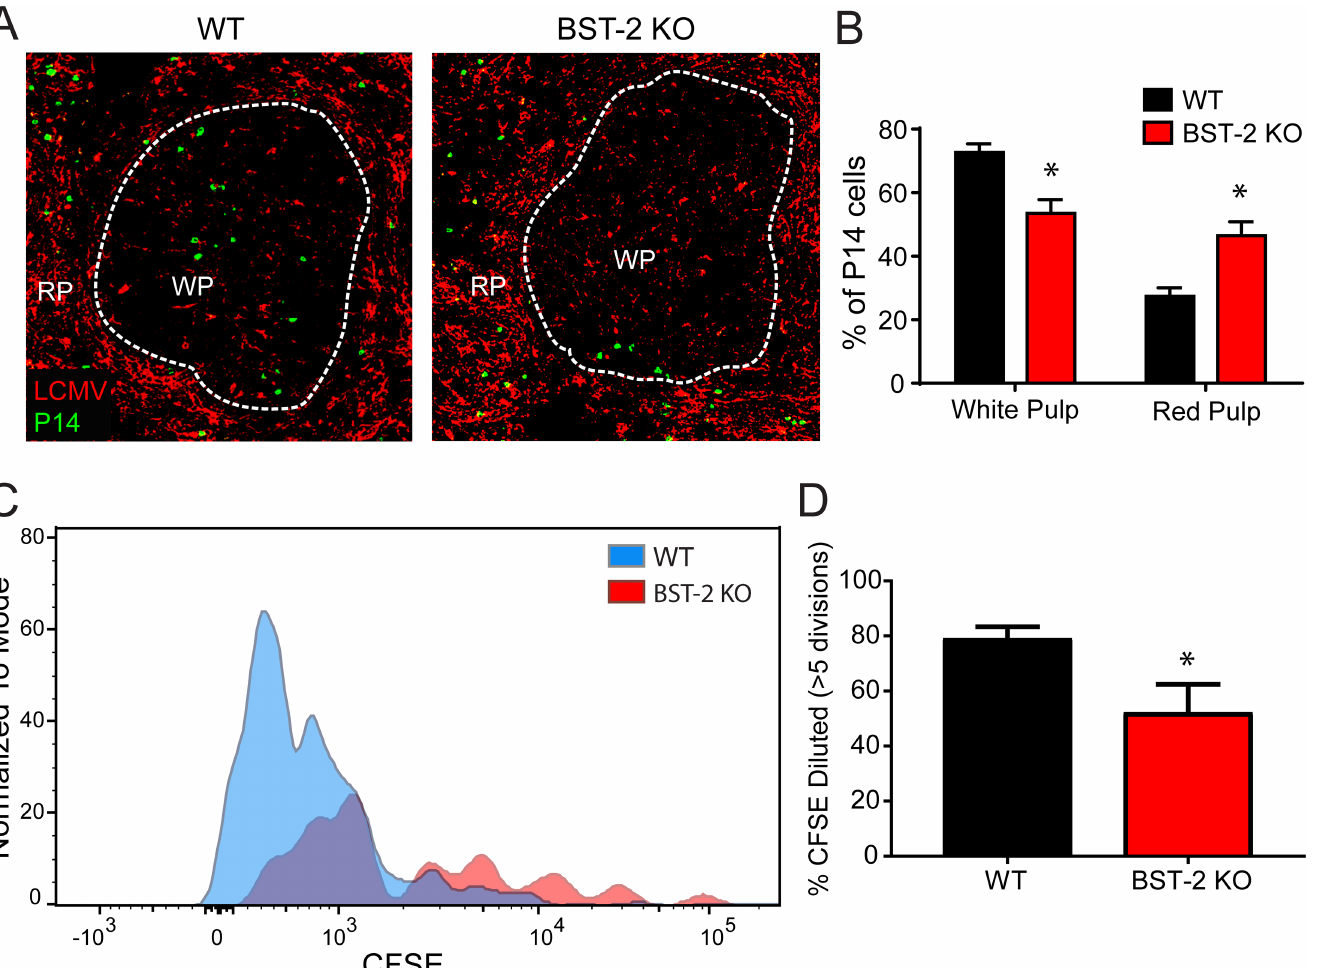
Fig 6. BST-2 deficiency changes the splenic distribution and proliferative capacity of antiviral CD8+ T cells. A. Representative confocal images were captured at day 4 post-infection in the spleens of WT and BST-2 KO mice seeded with mOrange+ P14 cells (green). The splenic distribution of P14 cells in relation to LCMV Cl- 13 (red) is shown. The white dotted line demarcates the border between the white pulp (WP) and red pulp (RP). B. The bar graph shows quantification of the white vs. red pulp P14 percentage in WT vs. BST-2 KO mice (n = 4 mice per group; 2 independent experiments). Data are represented as mean ± SD. Asterisks denote statistical significance ( (cid:3) P < 0.05). C. The representative histogram depicts the dilution of CFSE in P14 cells from WT (blue) vs. BST-2 KO (red) mice at day 3 post-infection. D. The bar graph shows quantification of the CFSE dilution data in panel C (n = 4 mice per group; 2 independent experiments). Graphed are the percentage of P14 cells that divided more than 5 times. Data are represented as mean ± SD. Asterisks denote statistical significance ( (cid:3) P (cid:20) 0.05).